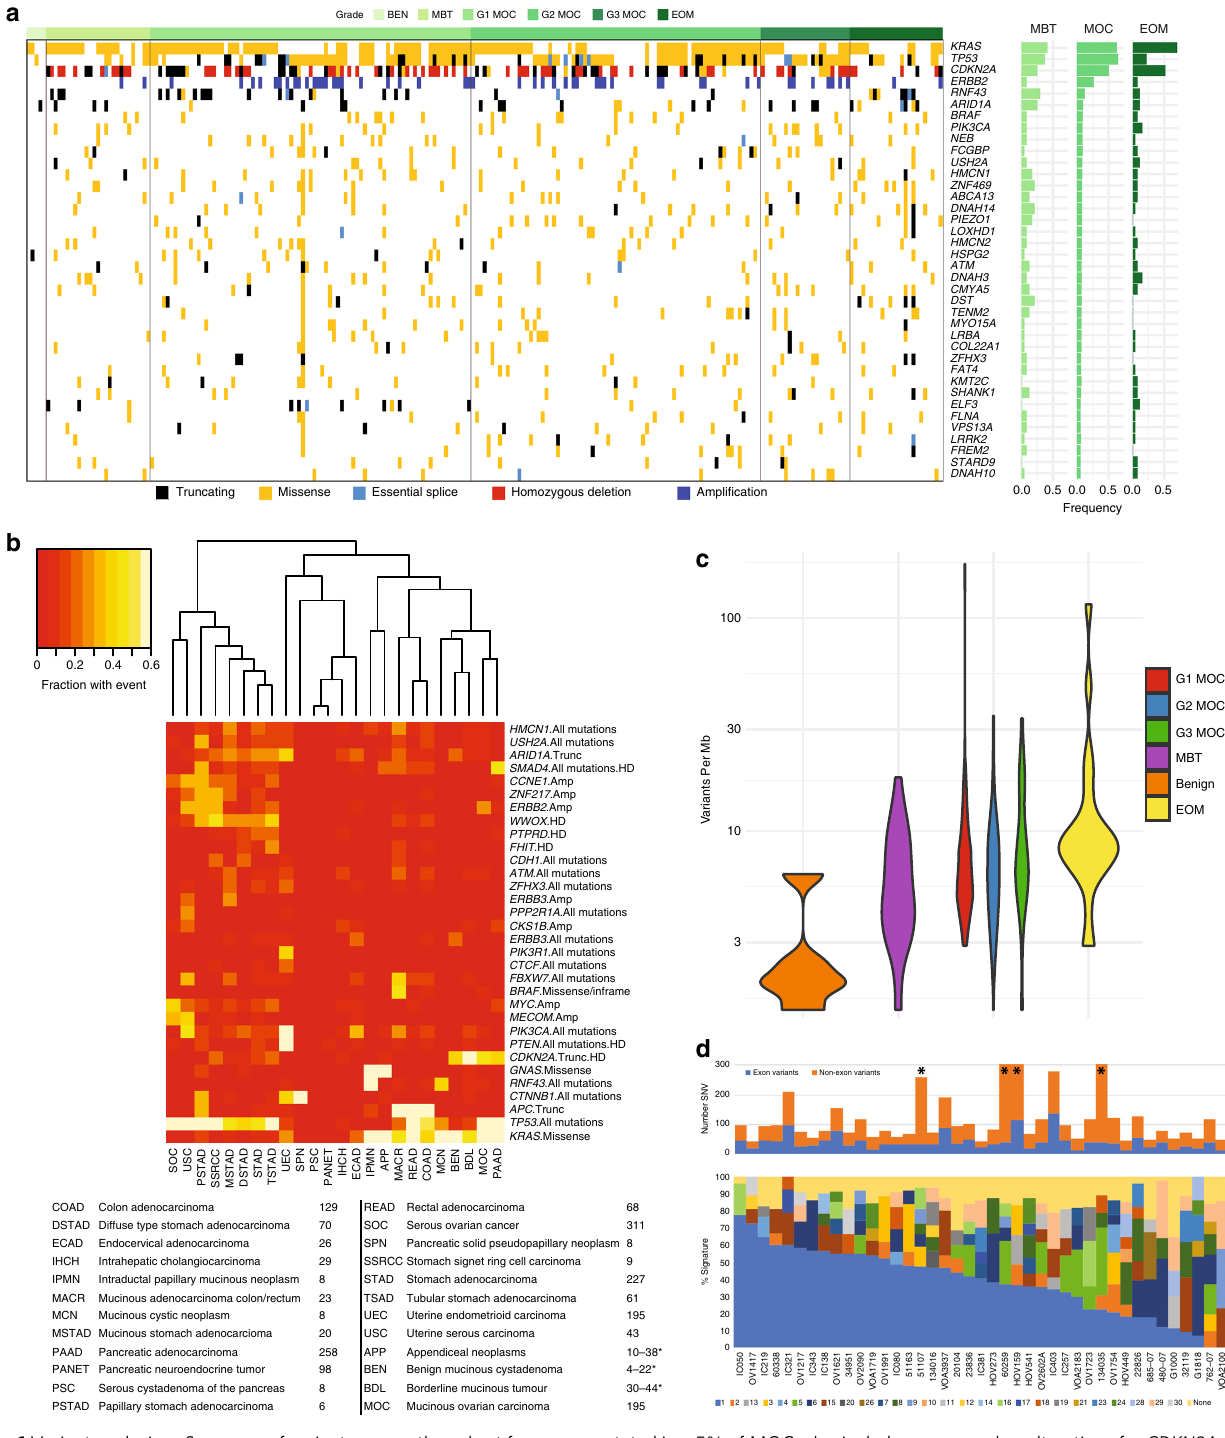
Fig. 1 Variant analysis. a Summary of variants across the cohort for genes mutated in > 5% of MOC; also includes copy number alterations for CDKN2A and ERBB2 . BEN, benign mucinous; MBT, borderline mucinous; MOC, mucinous ovarian carcinoma; EOM, extra-ovarian metastases. b Comparison of copy number alterations and mutations with other tumor types, summarised by frequency for each. Number of cases shown below. *Higher number is for selected genes tested by Sanger sequencing/SNP arrays (see Methods); lower number from exome analysis. c Number of variants per Mb by group (ANOVA, two-sided, F = 1.55, df = 5, p = 0.18), combining exome and targeted sequencing cohorts. d Top: number of single nucleotide variants (SNV) input to signature detection from whole exome and whole genome sequencing, with each column an MOC case. Note whole genome samples truncated at 300 (asterisk). Bottom: COSMIC mutation signatures